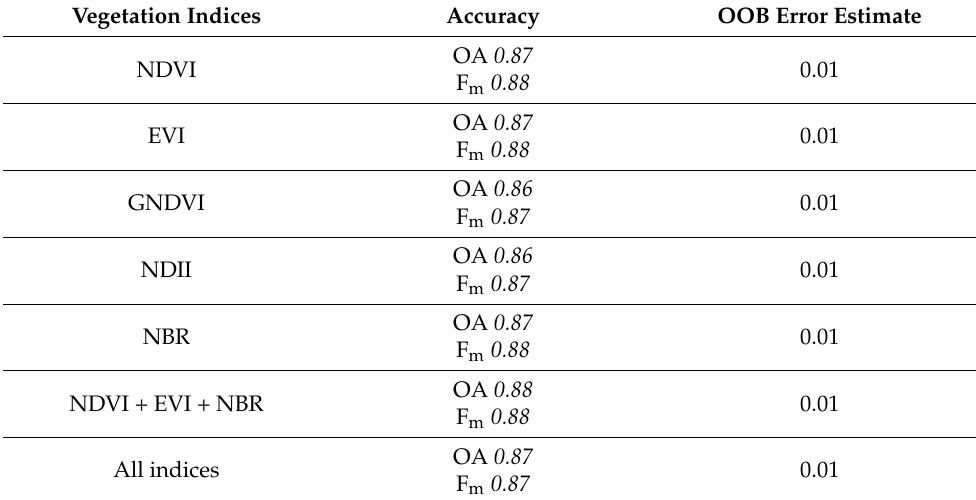
estimate values for the random forest (RF) algorithm are reported.